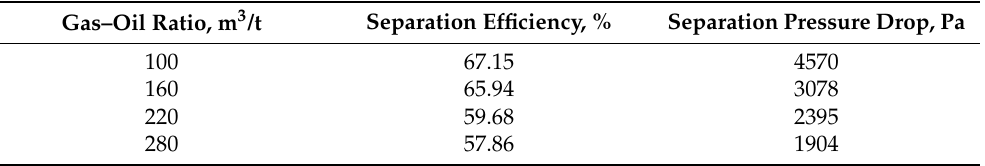
Table 5. Effect of the gas–oil ratio on the gas–liquid separation performance. Gas–Oil Ratio, m 3